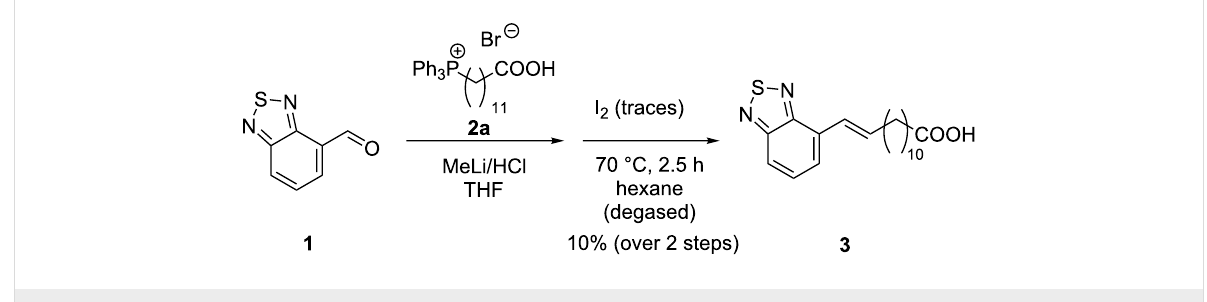
Scheme 1: Synthesis of fatty acid 3 with one olefinic unit.